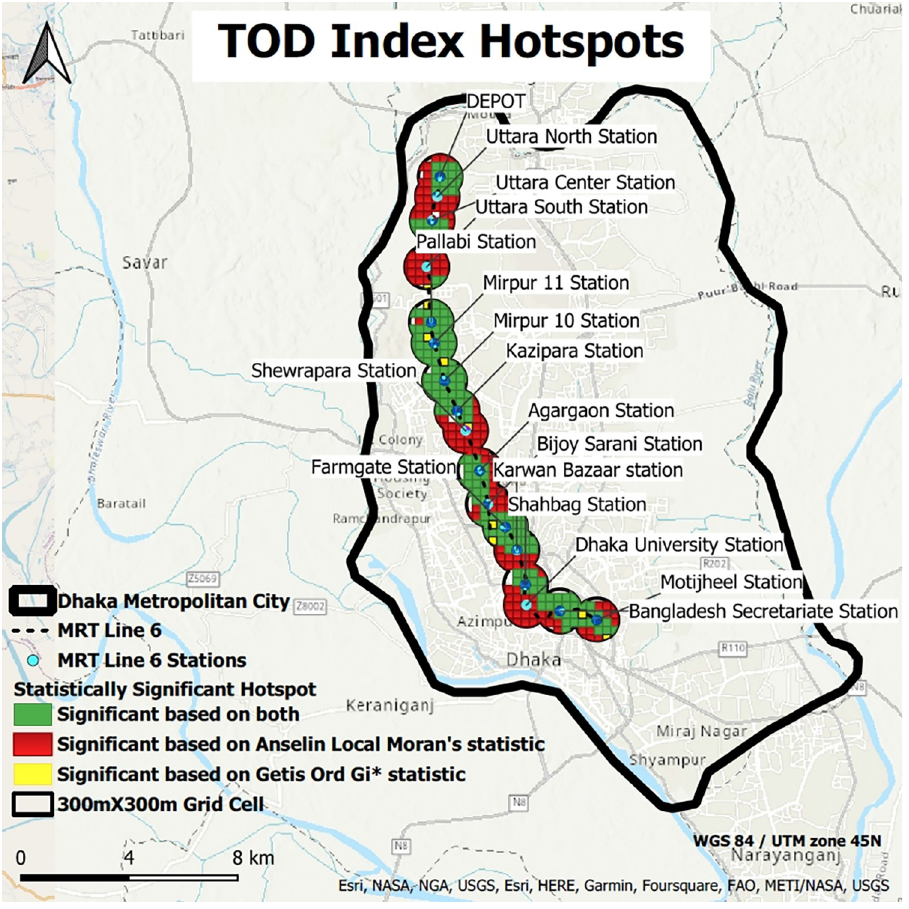
Fig 9. TOD index hotspots (source: Map is prepared by authors using base map from https://apps.nationalmap. gov/viewer). Figure is similar but not identical to the original image and is therefore for representative purposes only.